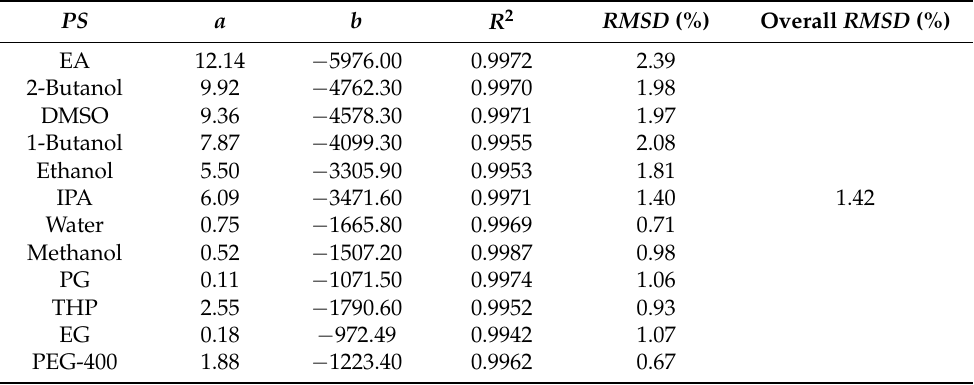
Table 6. Results of van’t Hoff model in terms of model parameters ( a and b ), R 2 and RMSD for ECT in various PS c .